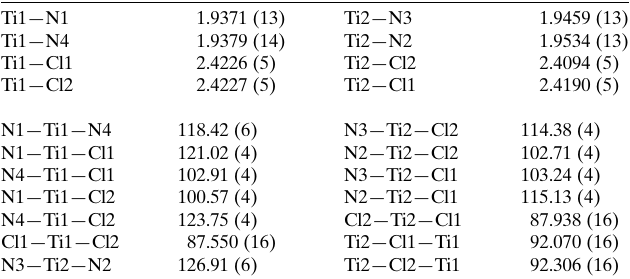
Table 2 Experimental